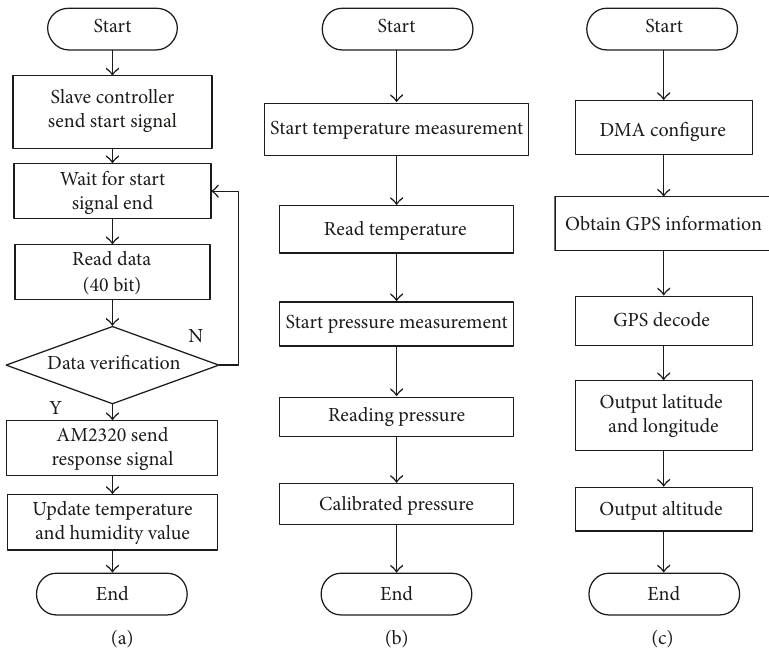
Figure 15: (a) Temperature and humidity collection. (b) Pressure collection. (c) Elevation, latitude, and longitude collection.